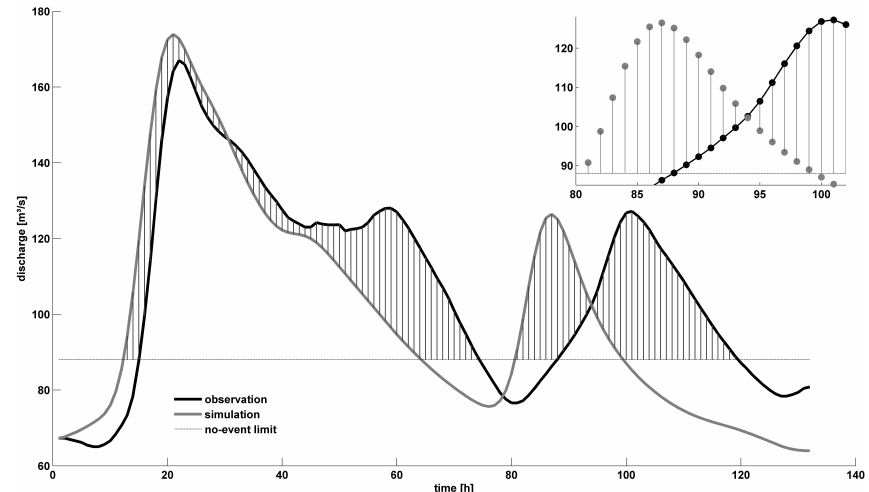
Fig. 9. Example of a matching observed (black) and simulated (grey) event (event 5 in Fig. 4). Connections (thin grey lines) between matching points of observation and simulation according to the RMSE are shown. Note that connections may exist between non-matching segments of the hydrographs (rise with recession or vice versa).